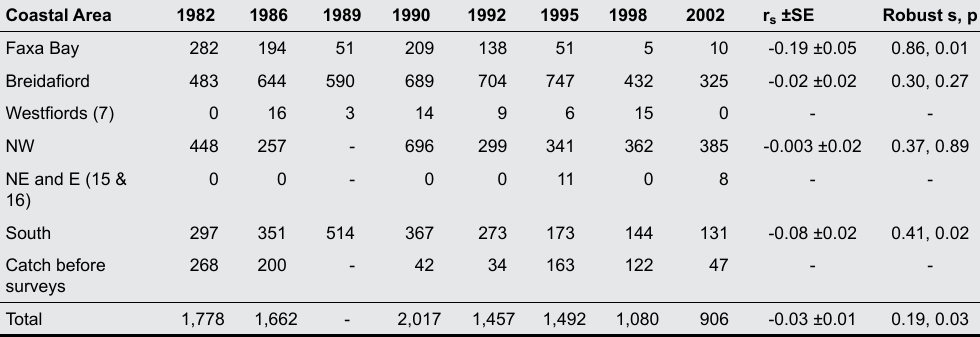
Table 4. Total number of pups on the coastal areas of Iceland where grey seals ( Halichoerus gry- pus ) breed. r s is estimated trend of log e (pups) with time (years from 1981), using robust regres- sion. Counts are not corrected for mortality or pups that may have been born after the survey was completed. Robust s is an estimate of the standard deviation of the error term, s = MAD/0.6745 (MAD mean absolute deviation; Hocking 2003).